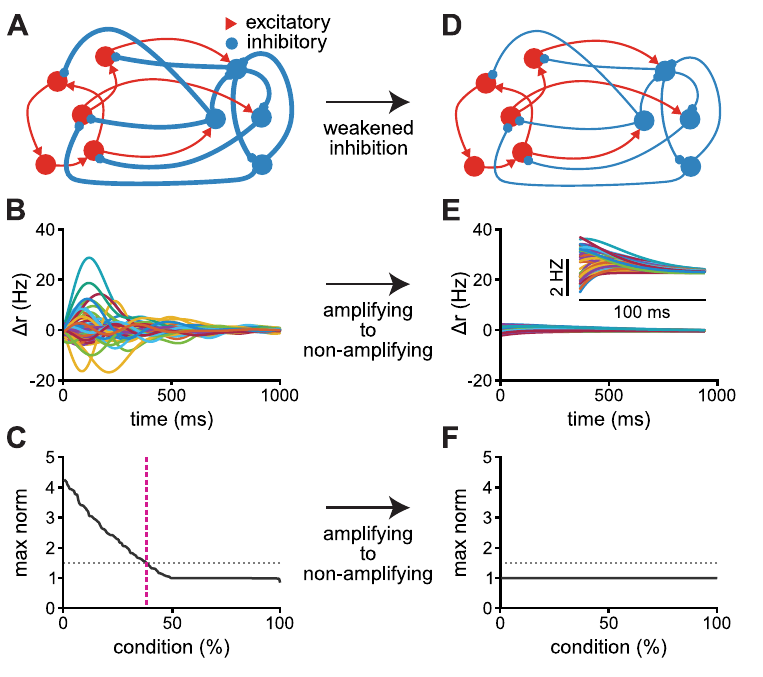
Fig 8. From short transient to non-amplifying with weakened inhibition. A , Schematic of a network with strong excitatory and inhibitory connections and I / E ratio of 40. B , The network’s dynamics given the preferred initialisation. The resulting network is in the short transient regime; the preferred initialisation yields amplifying dynamics. C , Maximum response norm for all orthogonal conditions, in decreasing order. Grey dotted line corresponds to a response norm that is 50% larger than the norm of the initial condition. Pink dashed line indicates the percentage of initial conditions with maximum norm larger than 50% of the initial condition. D , Schematic of the same network from panel A, but the inhibitory weights are scaled down by a factor of 40 (yielding an I / E ratio of 1), which could be interpreted as the resulting effect of modulation of the inhibitory neurons (or synapses). E , The dynamical response given the preferred initialisation; inset depicts the same dynamics on a different scale. F , Maximum response norm per condition. The network is unable to amplify any inputs. The maximum norm of the dynamics is equal to the norm of the initial condition (set to be 1) for all initialisations. The network is composed by 100 excitatory and 100 inhibitory neurons sparsely connected and without self loops. The schematics (panels A and D) is adapted from ref. [8].